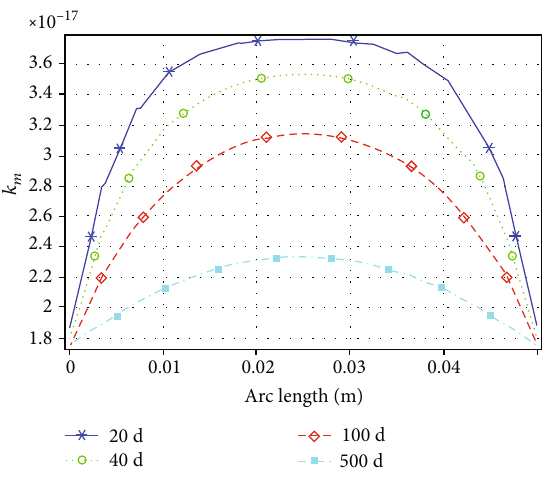
Figure 7: Evolution of permeability in the upper boundary fracture system.